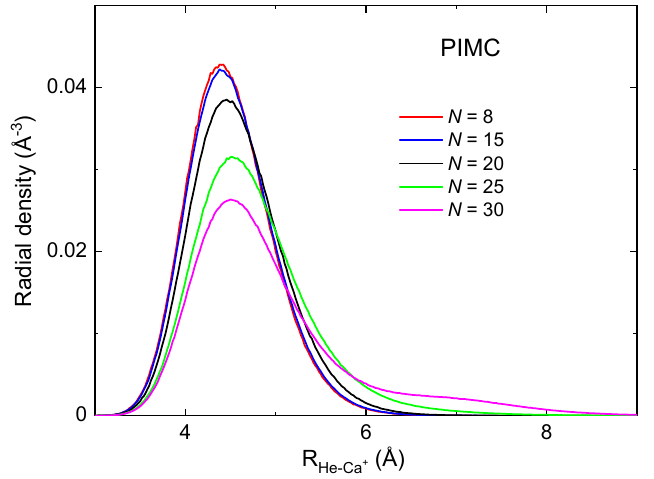
Figure 6. Cluster radial densities (in Å − 3 ) as functions of the He N Ca + distance (in Å) obtained by means of the PIMC method for different sizes of He N Ca + clusters: N = 8 (red), N = 15 (blue), N = 20 (black), N = 25 (green) and N = 30